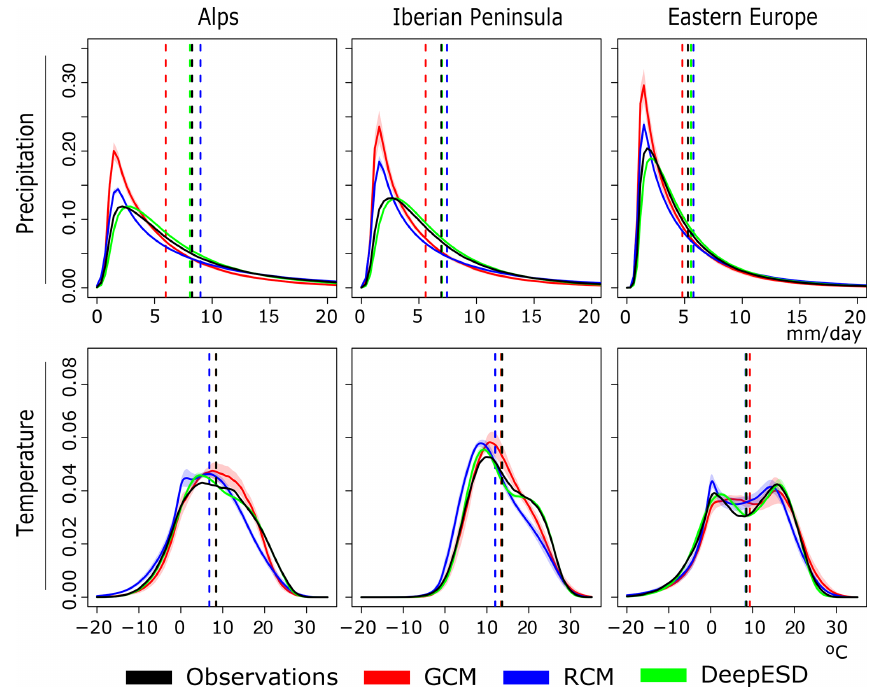
Figure 3. Probability density functions (PDFs) of the GCM (red), RCM (blue), and DeepESD (green) ensembles of precipitation and tem- perature over the historical period 1979–2005, as well as E-OBS (black) for the Alps, the Iberian Peninsula and Eastern Europe as defined in the PRUDENCE regions (Christensen and Christensen, 2007). The solid line represents the ensemble mean, and the shadow encompasses 2 standard deviations. The dashed line indicates the distributional mean of each